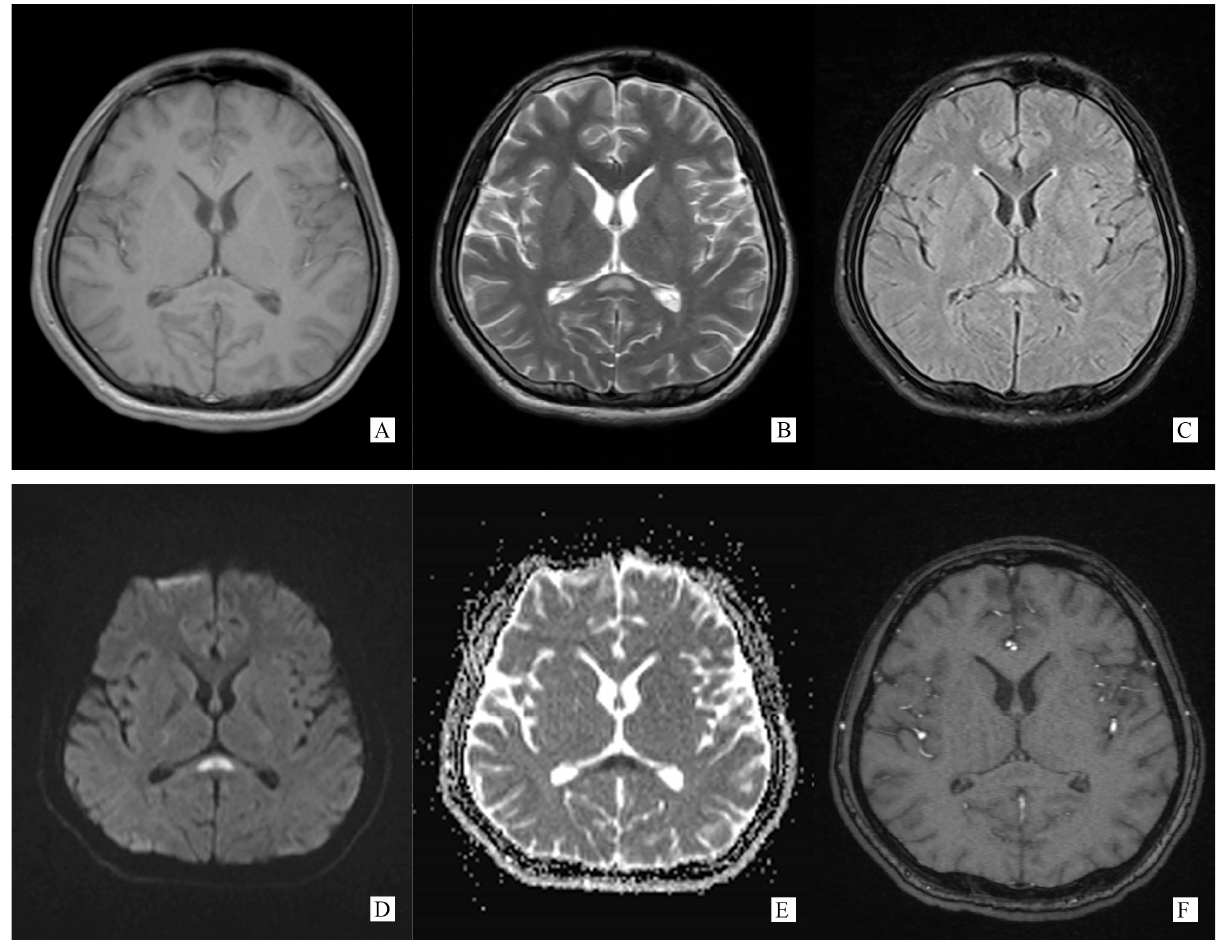
Figure 1. (Performed on 5 November 2021). ( A ) Axial T1 weight brain MRI image showing an oval hypointense lesion on SCC. ( B ) Axial T2 weight brain MRI image showing an oval hyperintense lesion on SCC. ( C ) Axial T2 flair weight brain MRI image showing an oval hyperintense lesion on SCC. ( D ) Axial DWI weight (b = 1000) brain MRI image showing an oval hyperintense lesion on SCC. ( E ) Axial ADC weight brain MRI image showing an oval hyperintense lesion on SCC. ( F ) Axial post-gadolinium T1-weighted brain MRI showing no enhancement on SCC lesion.